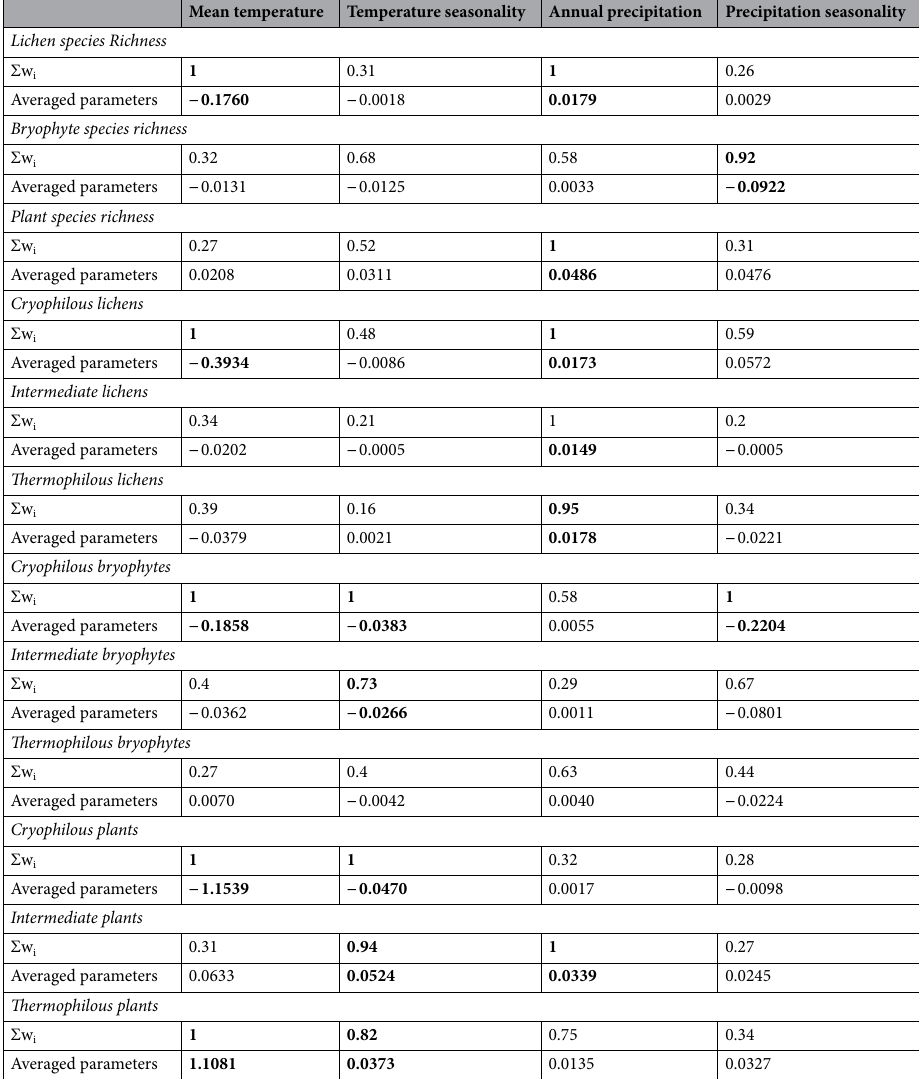
Table 2. Results of generalized linear mixed models. Σwi are the sum of Akaike weights, which can vary between 0 and 1. Variables with values close to one are more supported by the multi-model inference analysis. Value greater than 0.7 are shown in bold. Parameters shown are the averaged parameters for the subset models with ΔAICc <